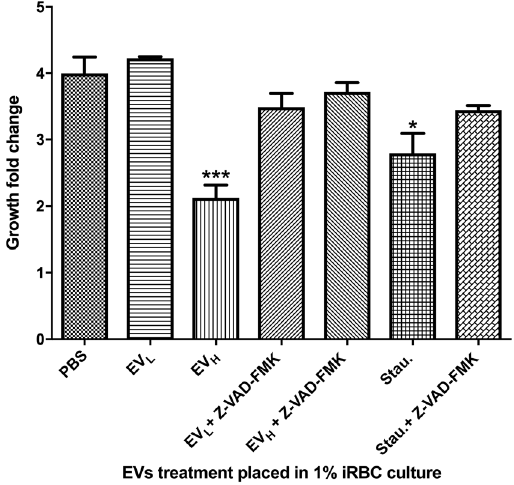
Figure 7. Rescued growth of P . falciparum after challenge with EV H in the presence of a pancaspase inhibitor. Growth fold change was measured by flow cytometry after distinct EV treatments with the addition or not of the pancaspase inhibitor Z-VAD-FMK. The average and S.D. of 3 replicas for each treatment is shown. (mean ± s.e.m.; n = 3 replicas), *** P < 0.005 and * P < 0.05 versus PBS control (Bonferroni’s test).